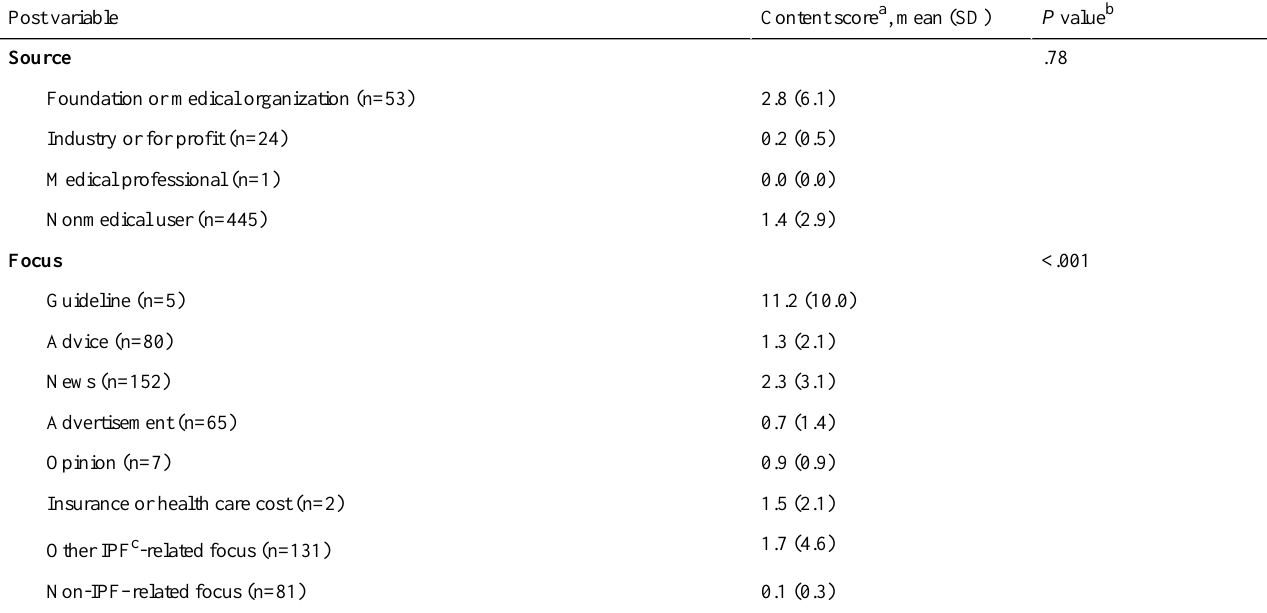
Table 2. Mean post content scores broken down by post source and content category from groups and pages